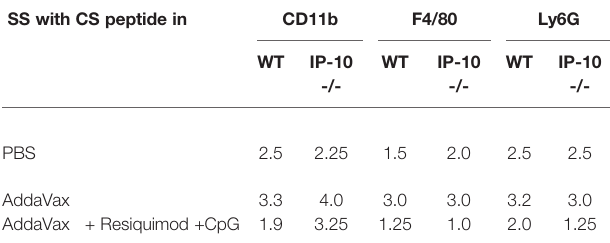
TABLE 1 | IHC of skin tissue from SS site of IP-10 -/- vs WT mice. SS with CS peptide